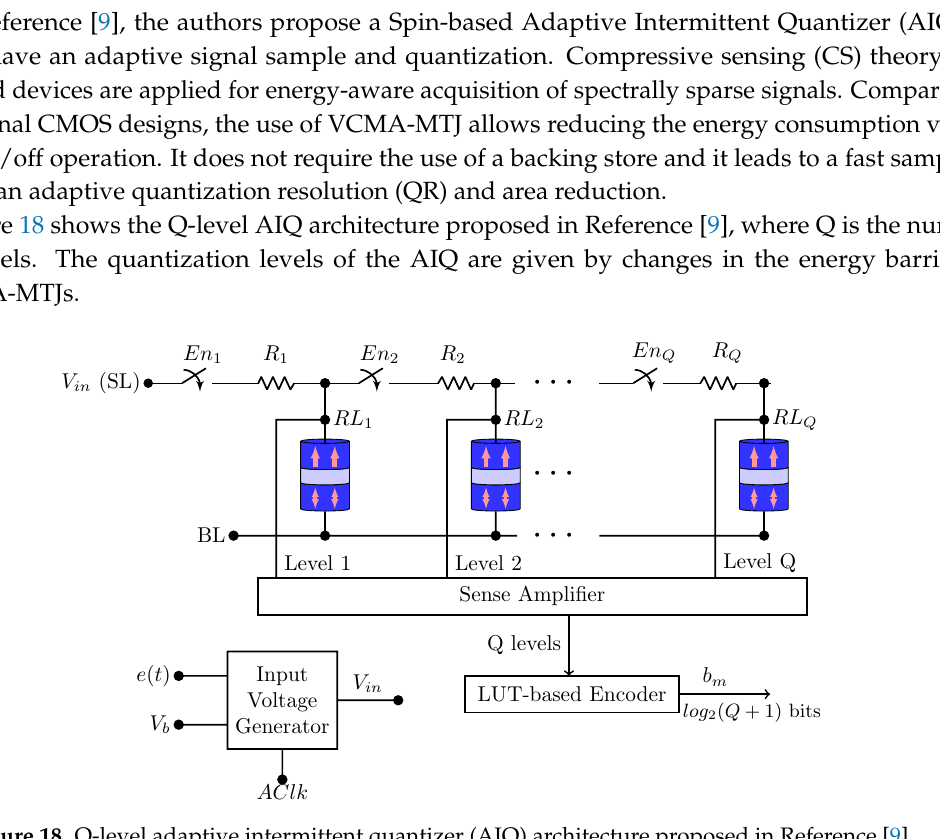
Figure 18. Q-level adaptive intermittent quantizer (AIQ) architecture proposed in Reference